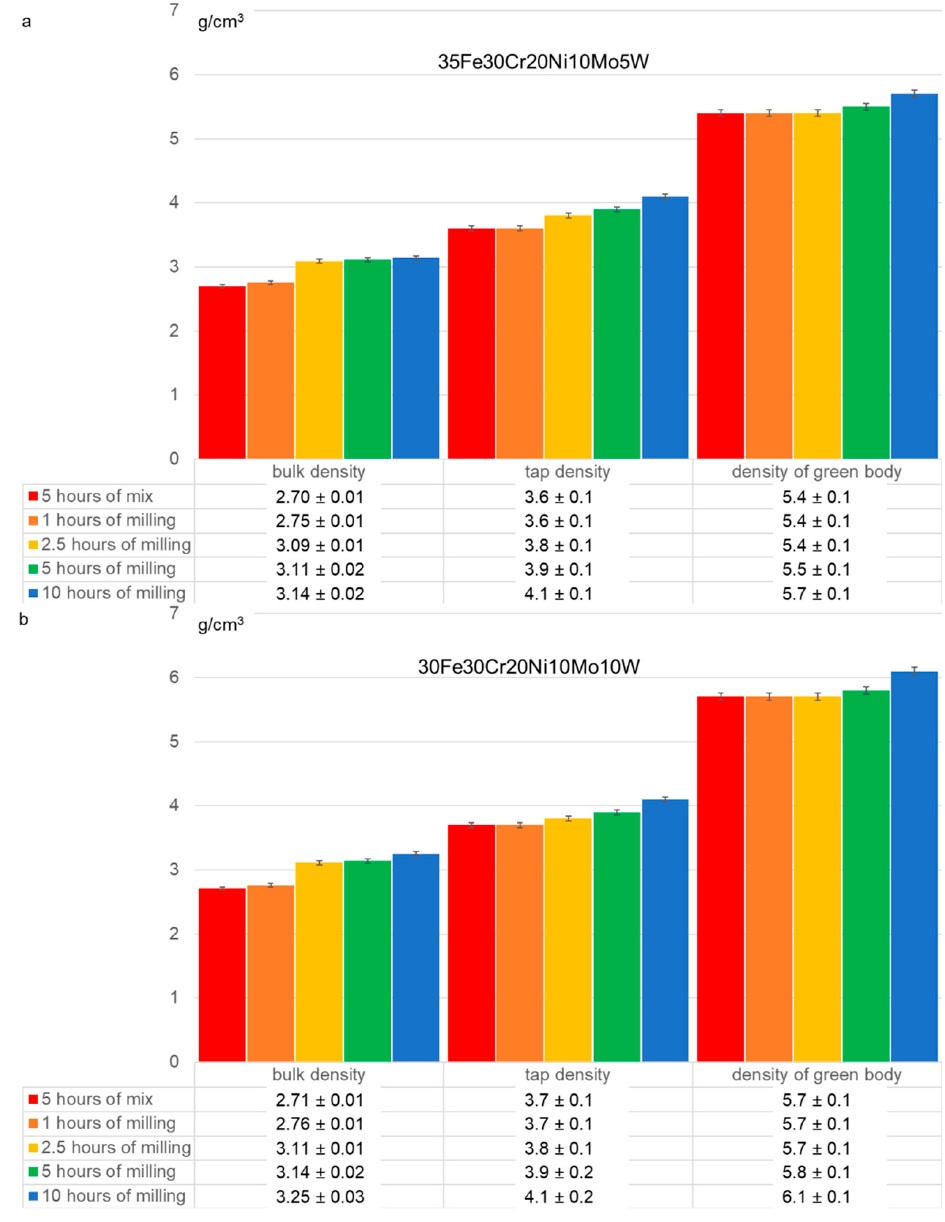
Figure 2. The effect of the powder preparation method on the bulk, tap density, and density of green bodies: ( a )—35Fe30Cr20Ni10Mo5W; ( b )—30Fe30Cr20Ni10Mo10W.